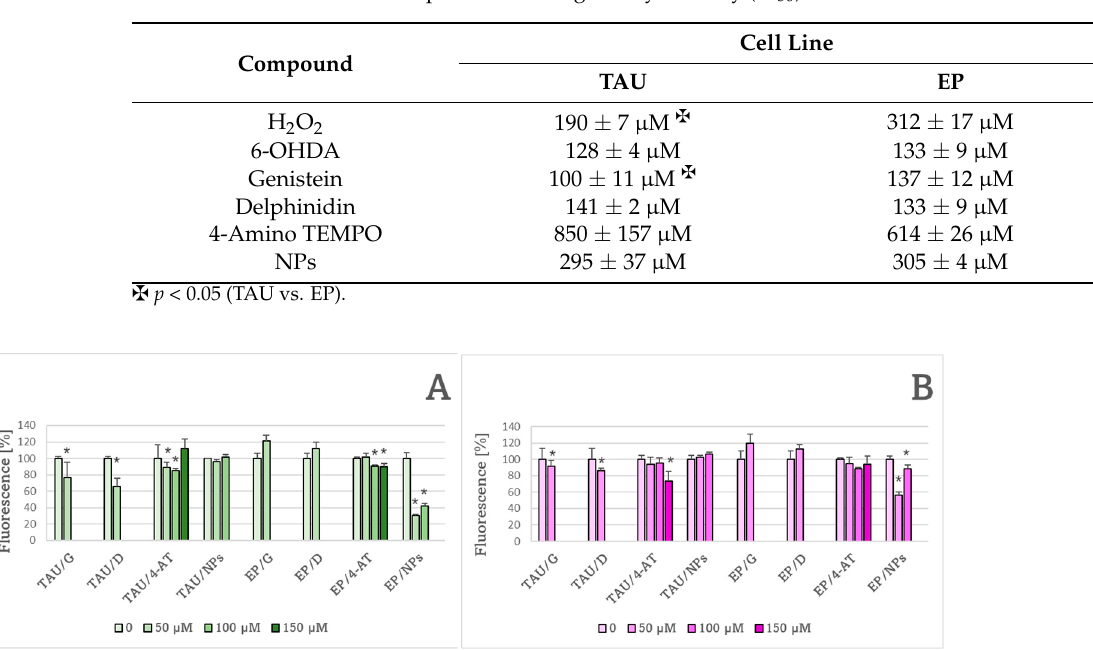
Figure 9. Effect of 24 h treatment with 50 μ M genistein (G) and delphinidin (D) and of various concentrations of 4-amino-TEMPO (4-AT) and nitroxide-containing redox nanoparticles (NPs) on ROS levels in TAU and EP cells, estimated with 2 ′ ,7 ′ -dichlorodihydrofluorescein diacetate ( A ) and dihydroethidium ( B ). * p < 0.05, compared to cells not treated with the antioxidant; n = 3. Treatment with the natural antioxidants genistein and delphinidin caused a decrease in the GSH content in both TAU and EP cells. 4-AT did not change the GSH content in TAU cells but caused an increase in the GSH content in EP cells, while NPs did not affect the GSH content in either cell type (Figure 10A). It should be recalled that the GSH level was significantly augmented in TAU cells with respect to EP cells (Figure 4). Only NPs significantly affected the GSSG content, decreasing it in EP cells (Figure 10B).